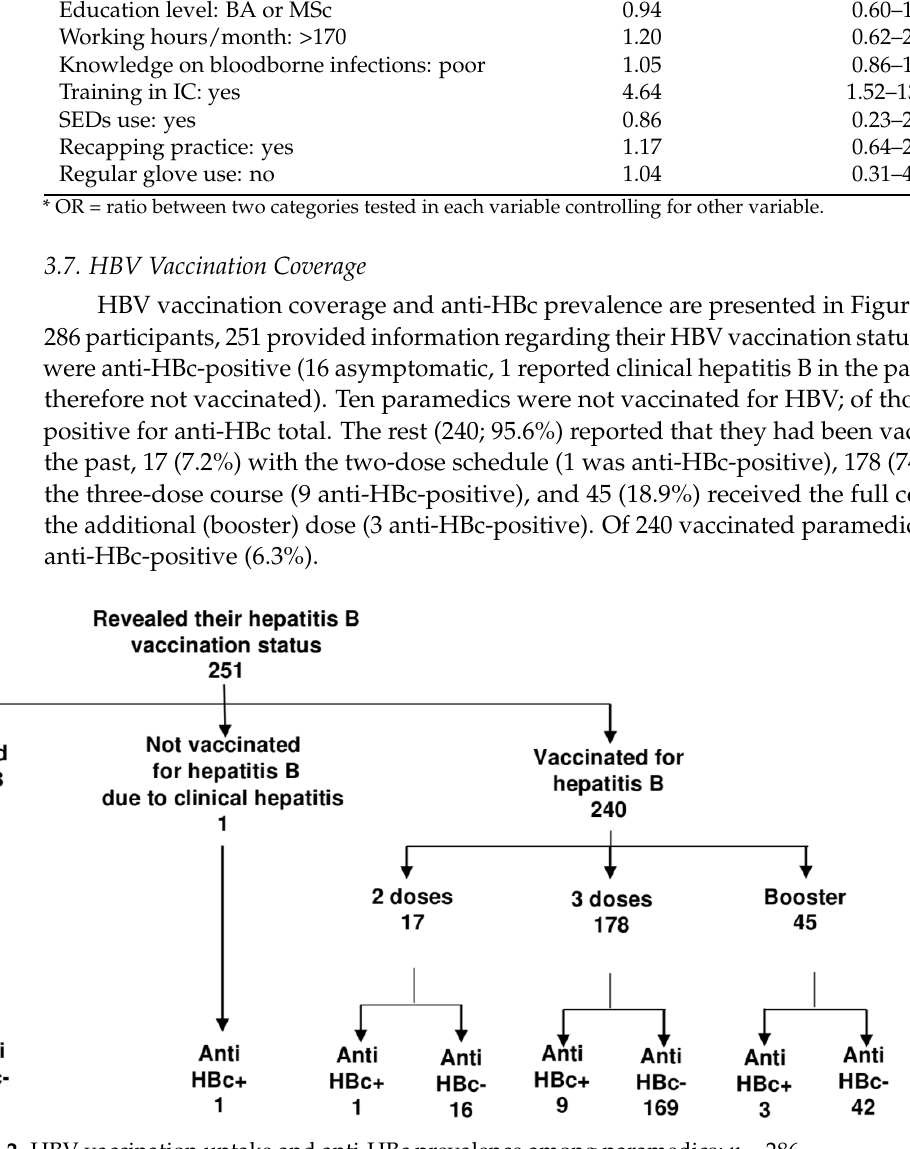
Table 3. Logistic-regression model: association of SIs with selected variables (odds ratios) ORs estimates *, 95% confidence intervals (CIs) of OR estimates; n = 286.